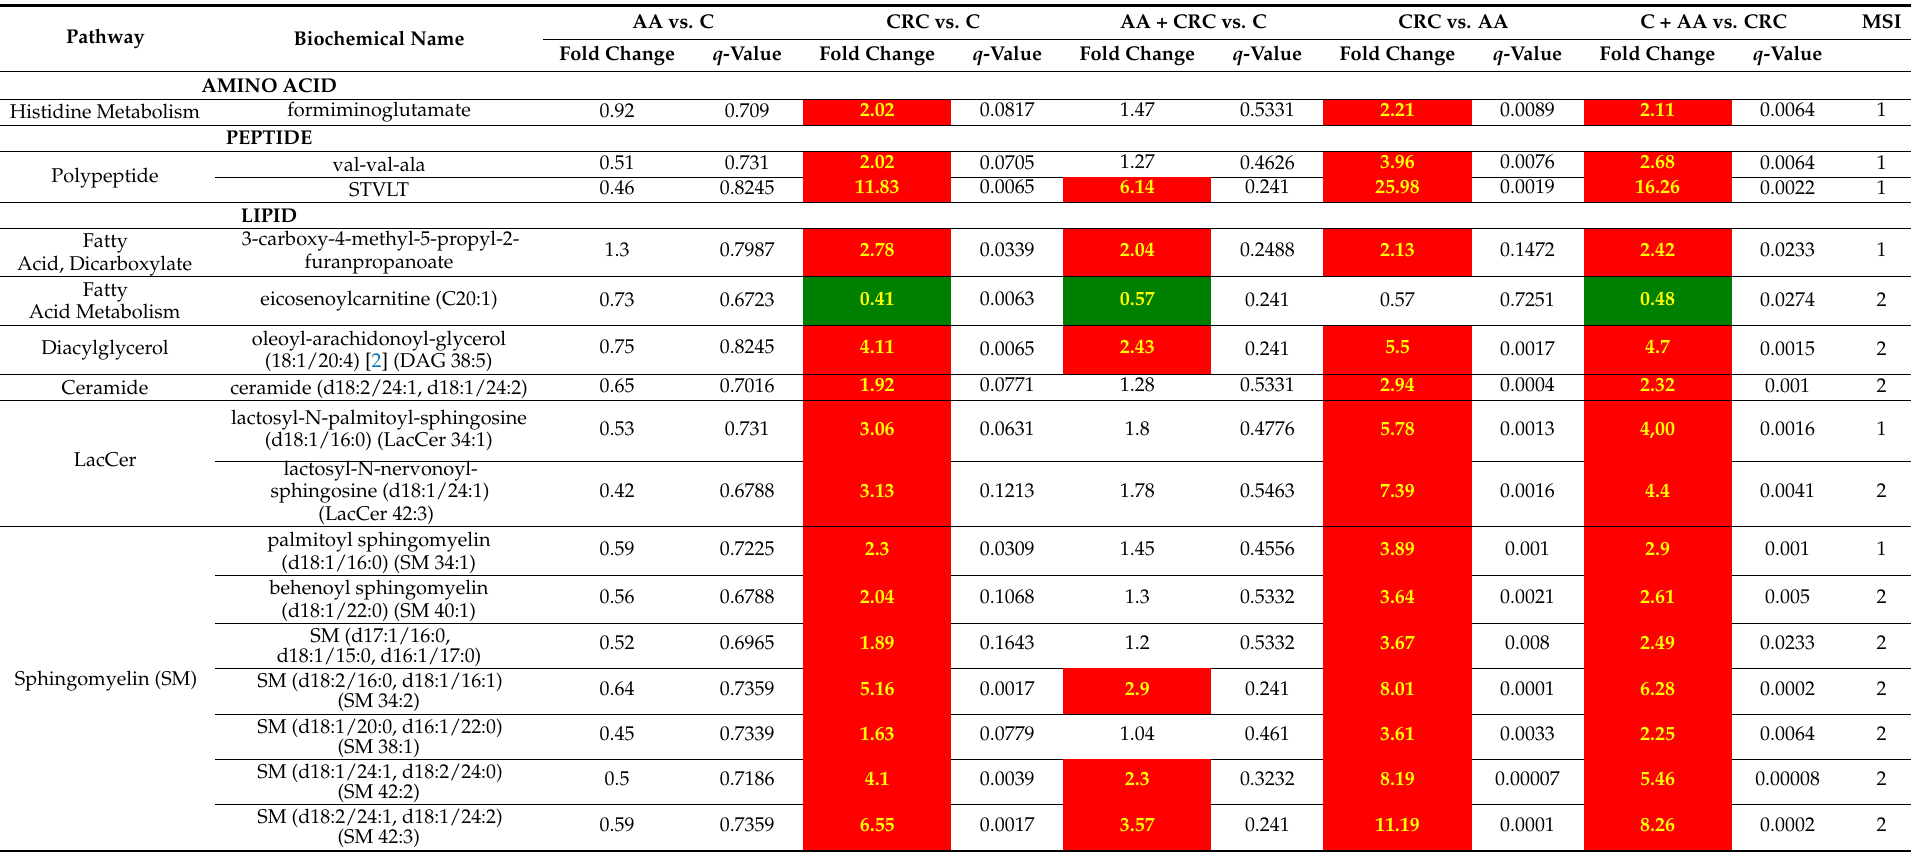
Table 1. Significant metabolites obtained by Welch’s two-sample t -test followed by FDR ( q -values ≤ 0.05), and fold-change heatmap, which indicates the ratio of the mean scaled intensity for each metabolite for the comparisons AA vs. Control (C), CRC vs. C, AA + CRC vs. C, CRC vs. AA, and C + AA vs. CRC. Red cells indicate that the mean values are significantly higher (upregulated) and green cells indicate the mean values are significantly lower (downregulated). MSI indicates the identification confidence level and C is the abbreviation of control